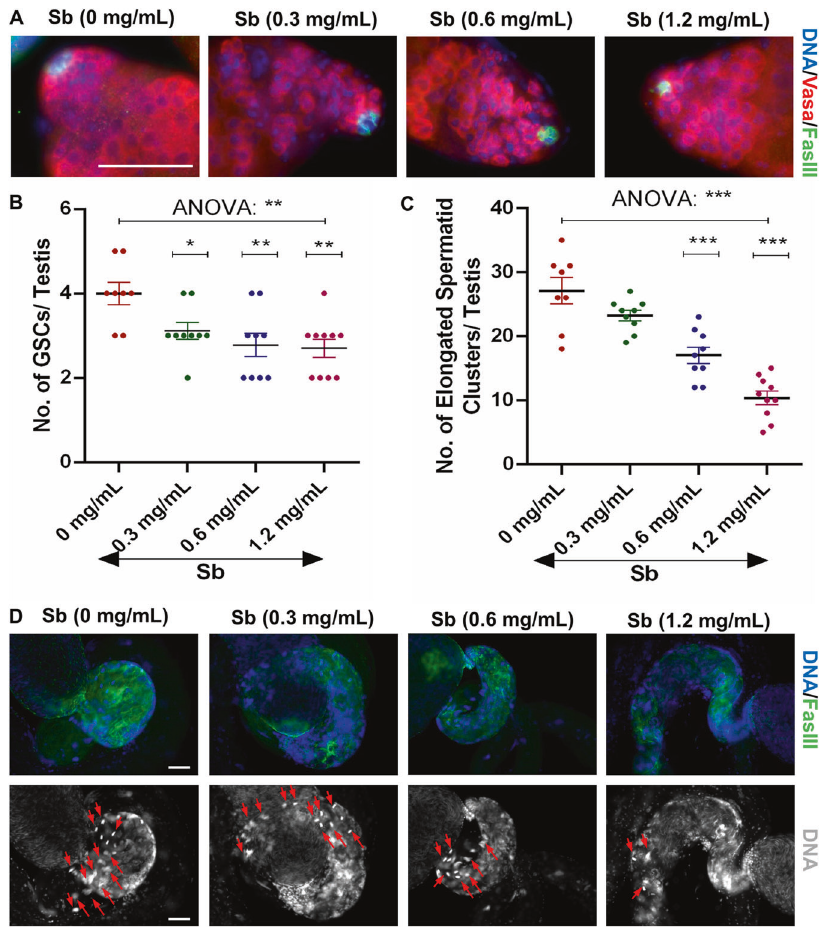
Fig. 1 Sb exposure injures the maintenance of GSCs and elongated spermatid clusters. A Immunostaining of Vasa (red) and FasIII (green) at the apex of testis under Sb exposure at 0 mg/mL, 0.3 mg/mL, 0.6 mg/mL and 1.2 mg/mL. B The number of GSCs per testis. C The number of elongated spermatid clusters per testis. D FasIII (green) immunostaining at the tail of testis under Sb exposure at 0 mg/mL, 0.3 mg/mL, 0.6 mg/mL and 1.2 mg/mL. DNA was stained with Hoechst33342 (blue or grey). Representative clusters of elongated spermatids were shown with red arrows. * P < 0.05, ** P < 0.01, *** P < 0.001, scale bar: 50 μ